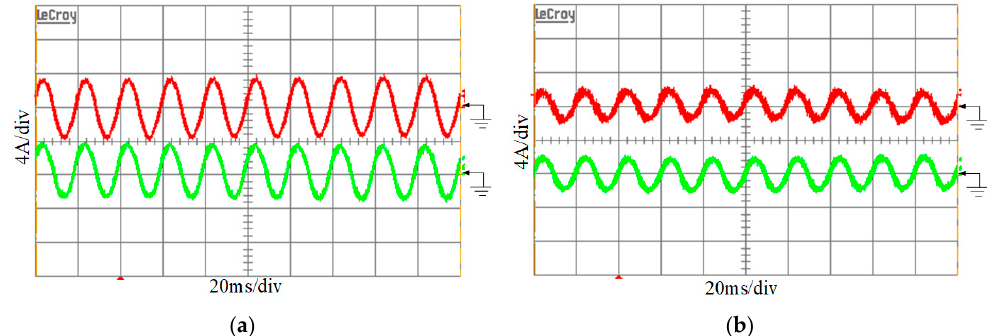
Figure 6. Output current of parallel system by using TPM in two different resistance loads. ( a ) R L = 50 Ω . ( b ) R L = 100 Ω .